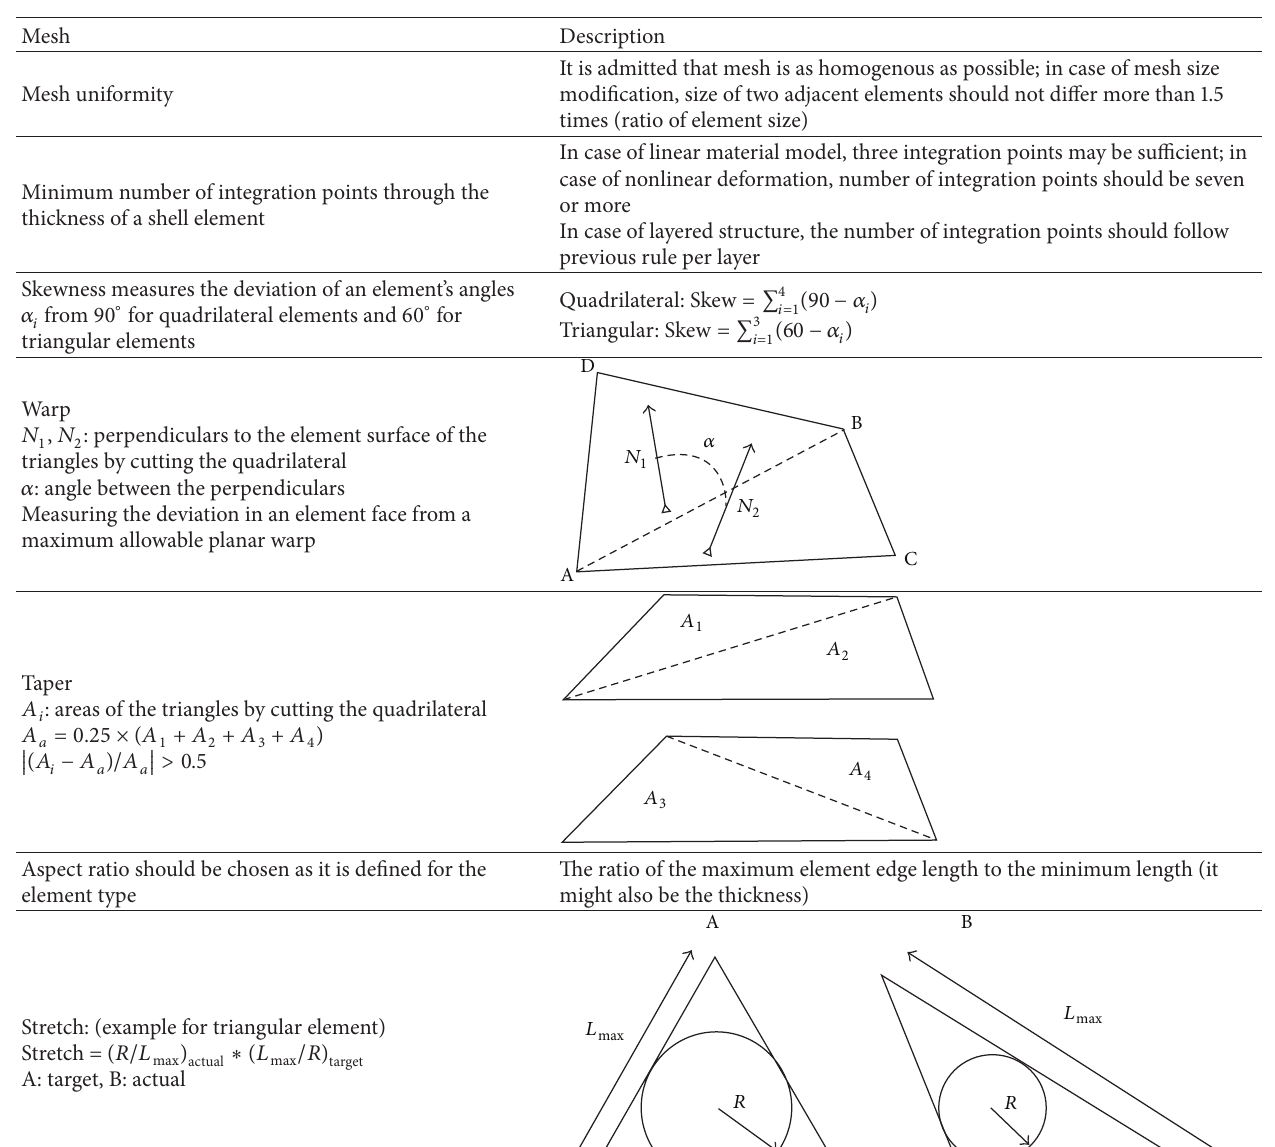
Table 3: Mesh conformity recommendations for shell and solid elements (see also [16]).